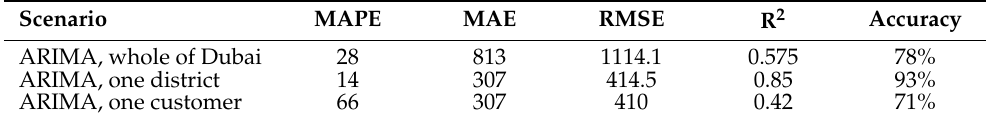
Figure 15. Actual and predicted load consumption values in MW versus time for the entirety of Dubai using the ARIMA model. Table 7. Evaluation metrics of the ARIMA model on the DEWA dataset for different